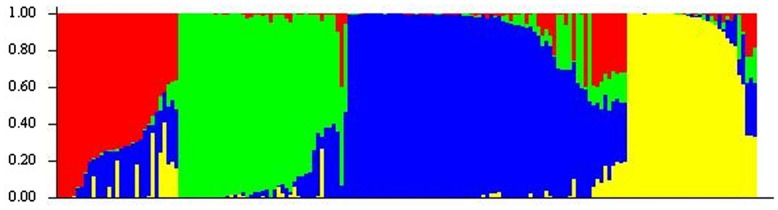
Estimated population structure of oat genotypes according to STRUCTURE software. Each individual is represented by a thin vertical segment, which can be partitioned into four colored segments that represent the individual estimated membership to the four clusters.